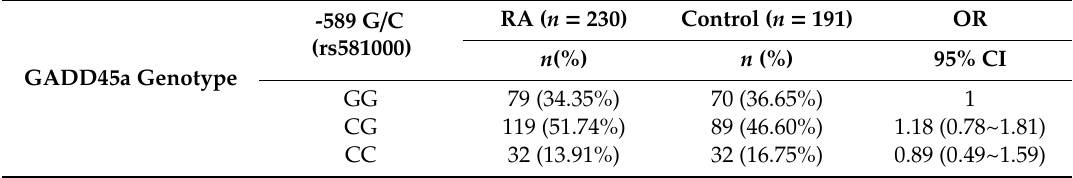
Table 2. Genotypes frequency of -589G / C GADD45a gene in RA and SLE patients.